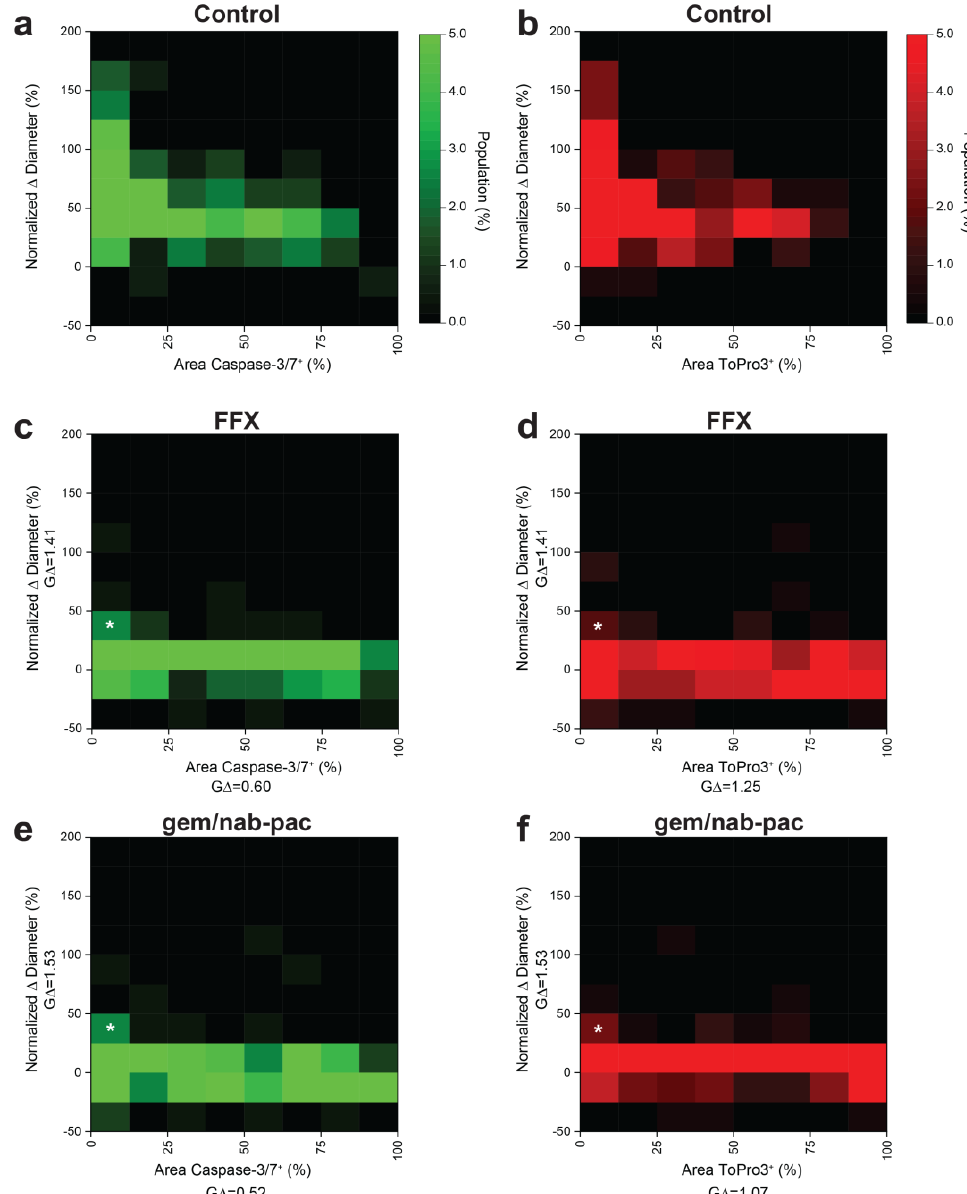
Figure 5. Multidimensional analysis of resistance PDAC organoids with residual markers of viability. ( a ) Heat map showing the population distribution of PDAC2 control organoids, including normalized ∆ diameter, plotted against ( a ) % area positive for caspase − 3/7 and ( b ) % area positive for ToPro3. ( c , d ) Heat map showing the population distribution of PDAC2 after 72 h FFX treatment, with normalized ∆ diameter, plotted against ( c ) % area positive for caspase − 3/7 and ( d )% area positive for ToPro3. ( e,f ) Heat map showing the population distribution of PDAC2 after 72h gem/nab-pac treatment with normalized ∆ diameter plotted against ( e ) % area positive for caspase − 3/7 and ( f ) % area positive for ToPro3. ( c – f ) Subclonal populations after treatment with residual growth [+25%, +50%] and <12.5% area positive for viability markers shown (white*).